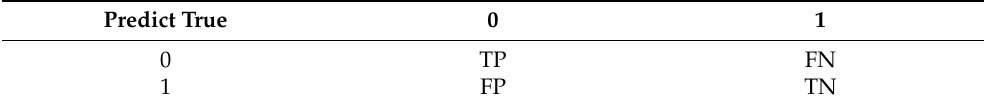
Table 4. Confusion Table 4. Confusion matrix.